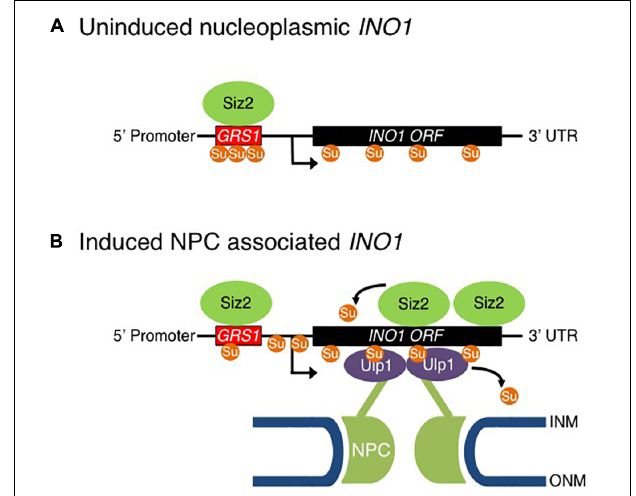
FIGURE 9 | Model for Sumo-mediated recruitment of INO1 to the NPC. Shown is model for the proposed role of sumoylation in the NPC targeting and transcriptional activation of the INO1 gene. (A) In a repressed state, INO1 is positioned in the nucleoplasm. (B) Reducing levels of inositol in the medium leads to recruitment of Siz2 to the INO1 locus and increased Siz2-mediated sumoylation of INO1 -associated proteins. These events are required for the targeting of the INO1 locus to the NPC where it interacts with NPC-associated Ulp1. Ulp1 supports the association of INO1 with the NPC and functions to desumoylation of INO1 bound proteins in regions containing the GRS1 and the ORF. Desumoylation of INO1 -associated proteins is proposed to promote INO1